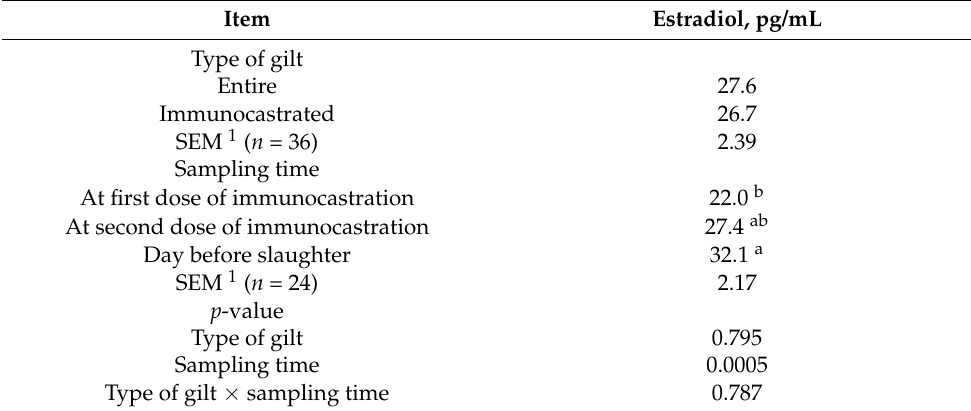
Table 4. Effect of immunocastration on serum estradiol concentration (least square means) of heavy gilts.